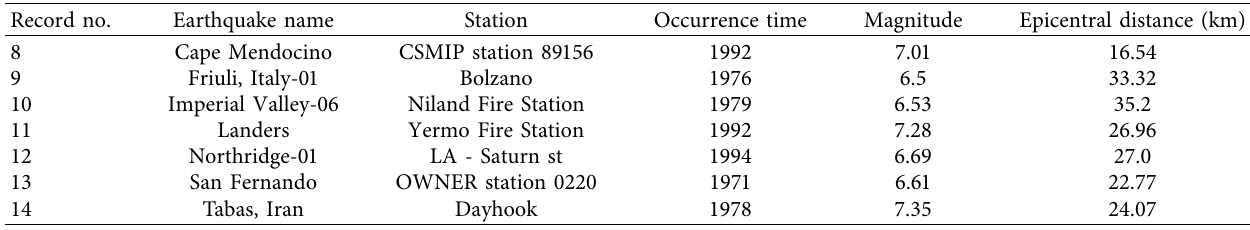
Table 7: Far-field earthquakes